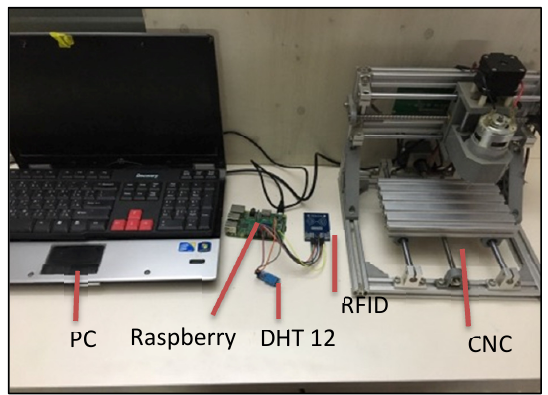
Fig. 8. System prototype.